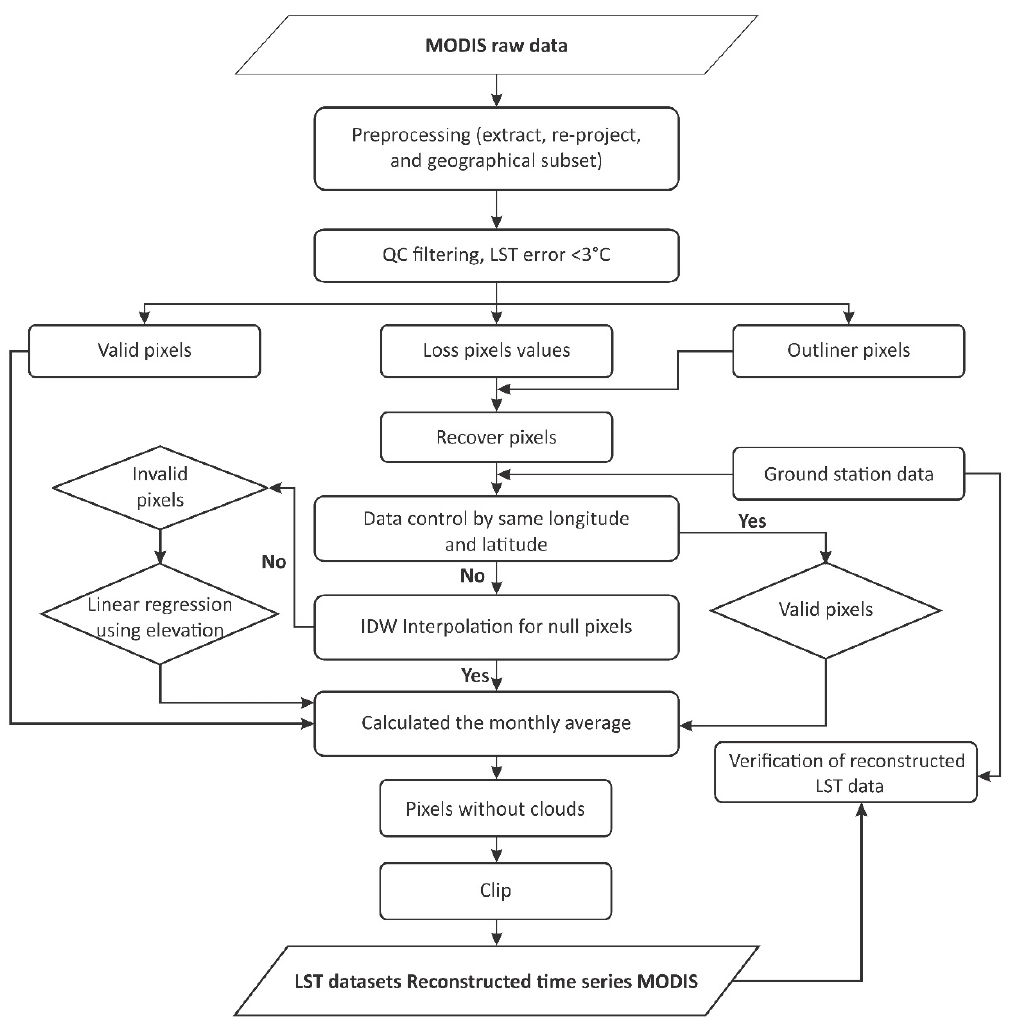
Figure 2. Flowchart showing a summary of the method used to fill the gaps in the MODIS LST